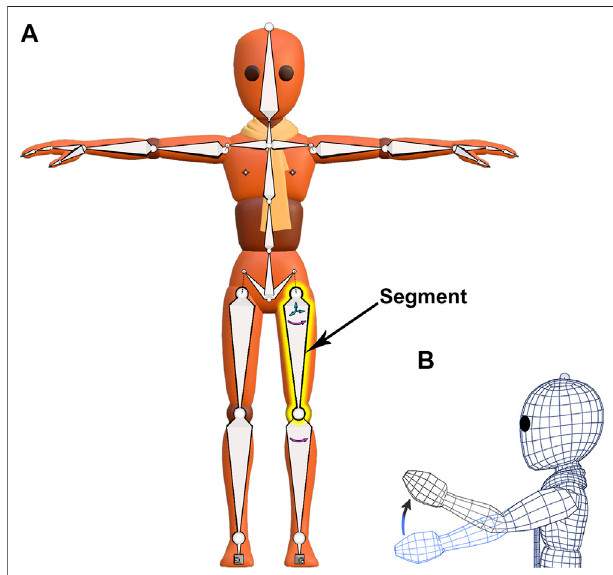
FIGURE 3 | A mesh character model from Blender ’ s Animation Fundamentals Rigs fi le with its armature visible. (A) An armature ( “ skeleton ” ) composed of segments is attached to an overlying mesh ( “ skin ” ) in a process called rigging. The segment highlighted in yellow has a disconnected start joint and can be both rotated and translated (small arrows). (B) Armature movement causes coordinated distortion of the overlying mesh, as illustrated in